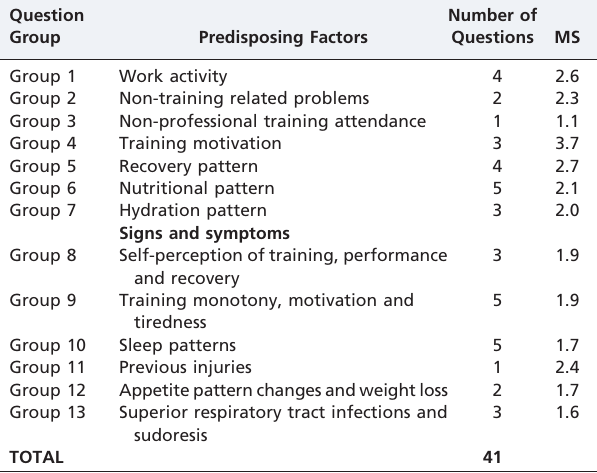
Table 2 - Analysis of the 13 question groups on the questionnaire (n =